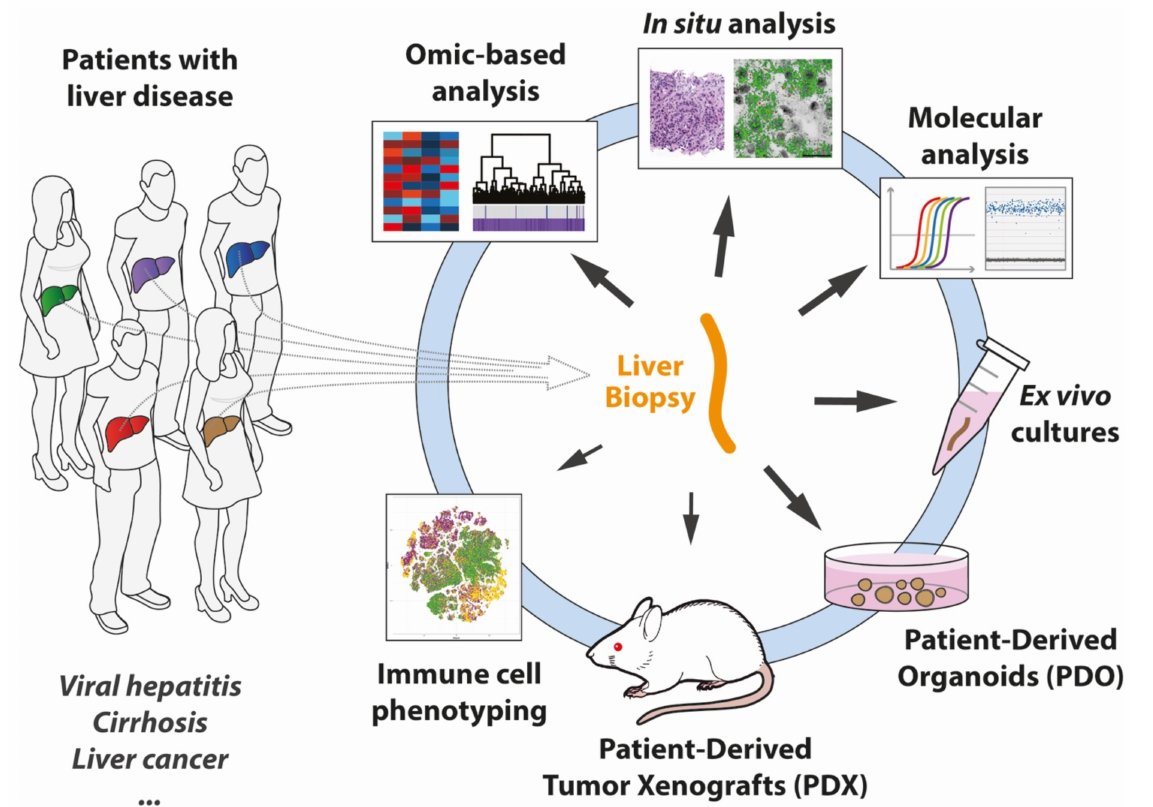
Figure 1. Liver biopsy tissue is the starting point for the study of liver diseases at the whole tissue and cellular level and the establishment of disease model